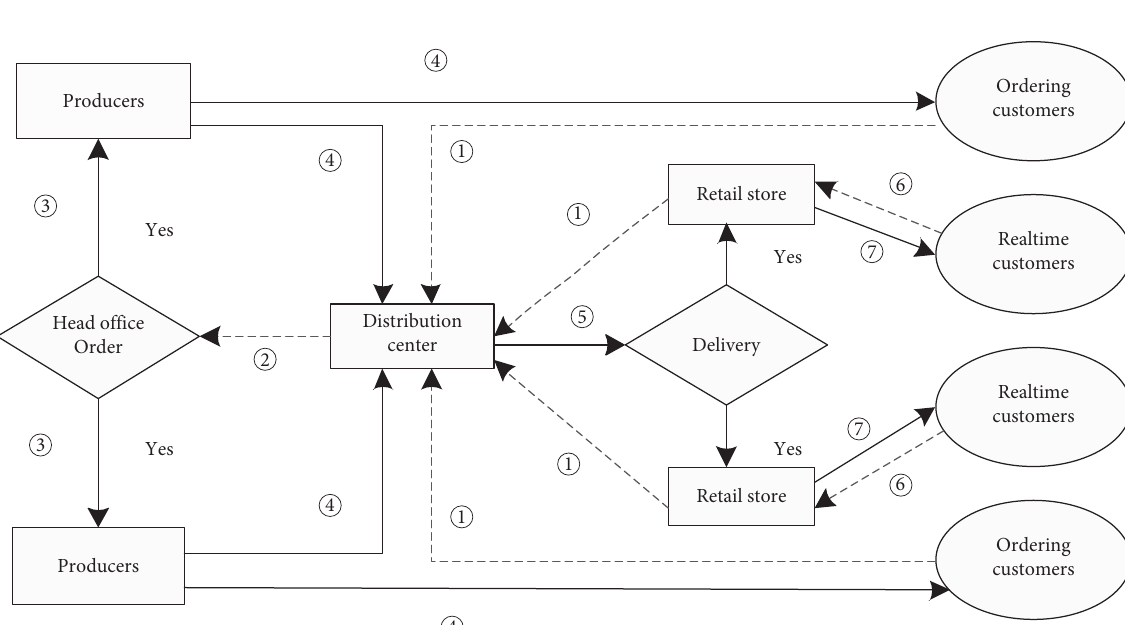
Figure 2: Purchase, distribution, and delivery of agricultural